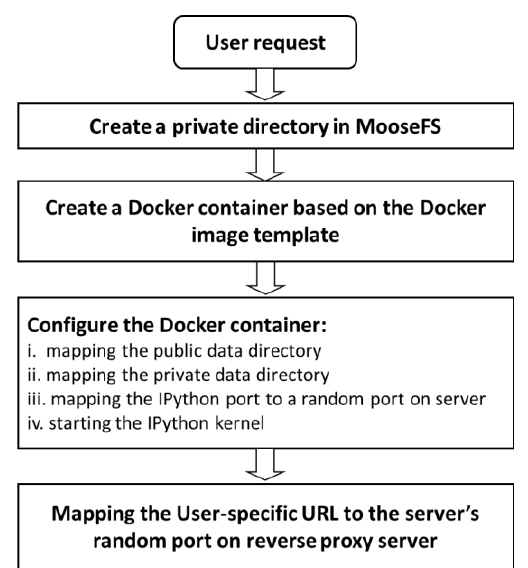
Figure 5. The management process of Docker containers